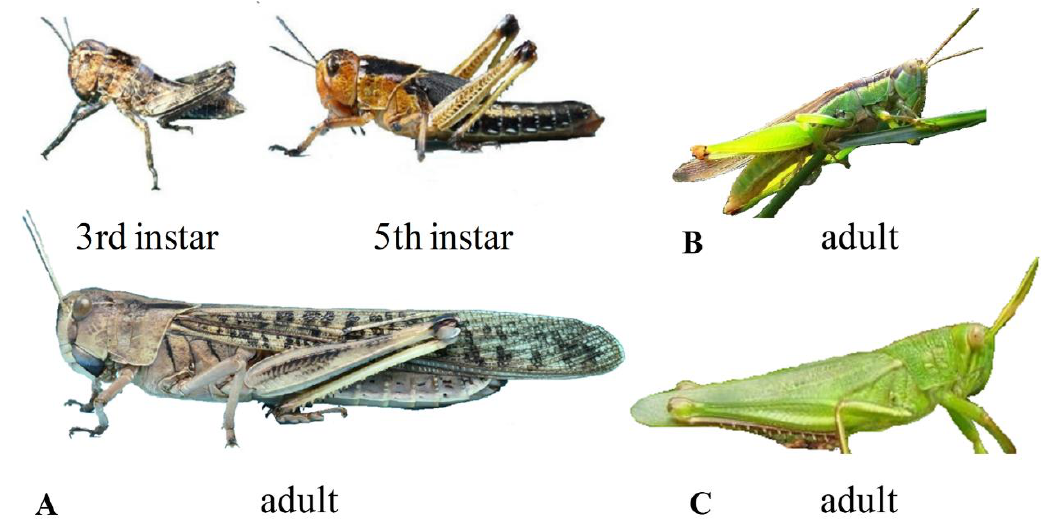
Figure 2. Di ff erences of external morphology among di ff erent species and instars. ( A ) presents AM Figure 2. Differences of external morphology among different species and instars. Note: A presents locusts; ( B ) presents rice locusts; and ( C ) presents cotton AM locusts; B presents rice locusts; and C presents cotton locusts.